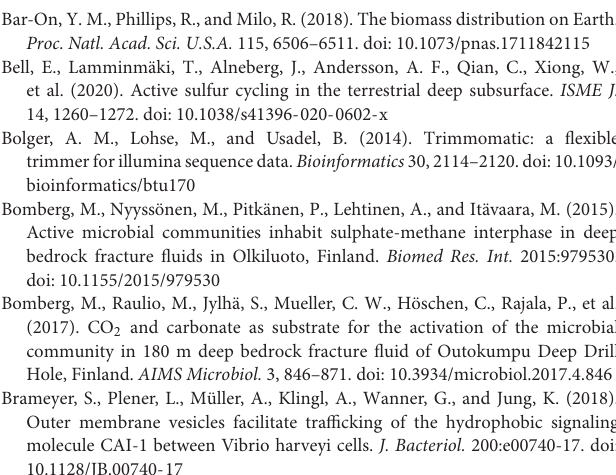
Supplementary Table 9 | METABOLIC analysis